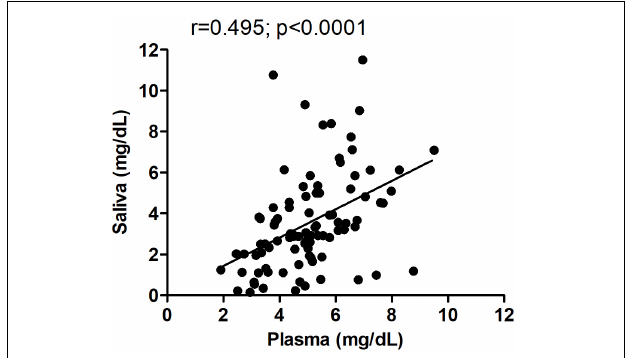
FIGURE 5 | Correlation between plasma and salivary levels of uric acid (UA). The correlation between plasma and salivary levels of UA was determined using Spearman correlation analysis. Pearson r = 0.495; p < 0.0001. The same subjects provided paired saliva and plasma samples; however, for some subjects, the saliva and plasma were collected on different days spaced up to a week apart.